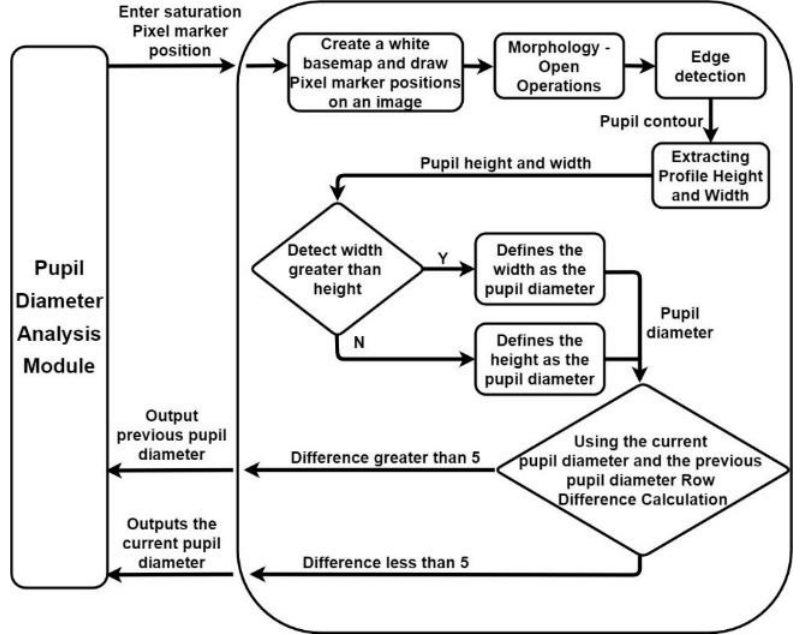
Figure 40. Developed pupil stateful recognition service mechanism (PRSSM)-based pupil diameter analysis module.